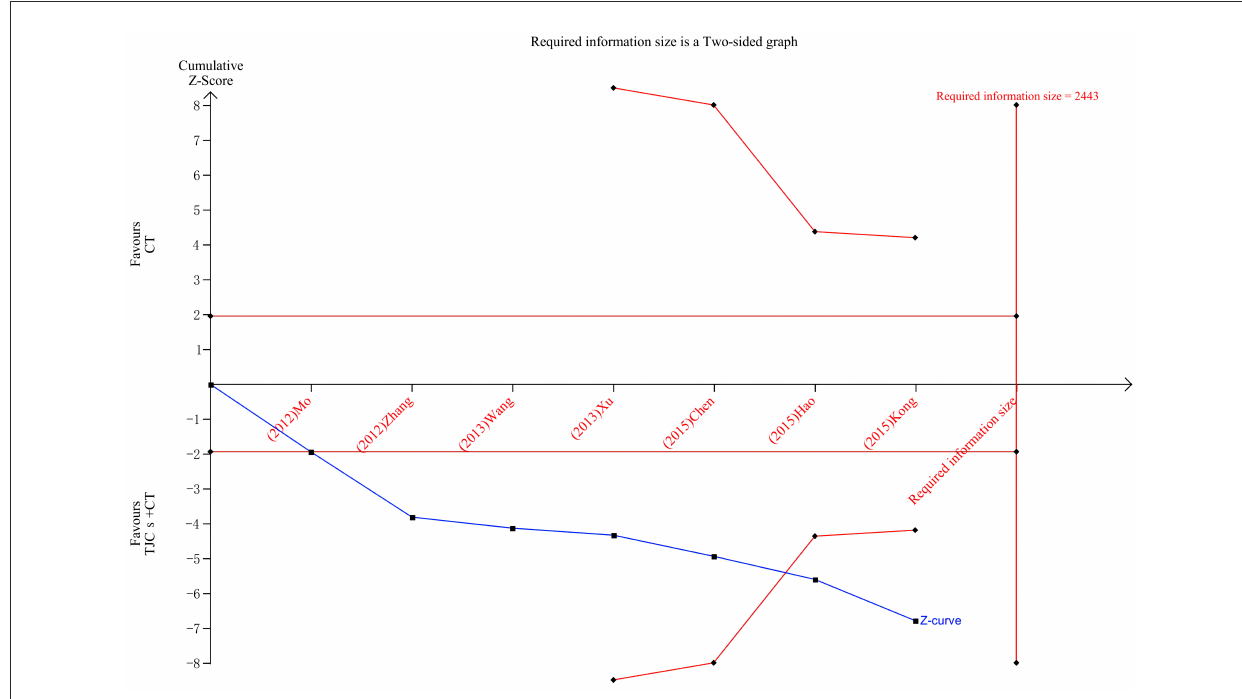
FIGURE8 TSA of the total effective rate of TJCs + CT in the treatment of DPN. Red curve, TSA boundaries; Red vertical line, required information size; Blue curve, Cumulative Z-values; Black dashed line, Traditional cut-off values.